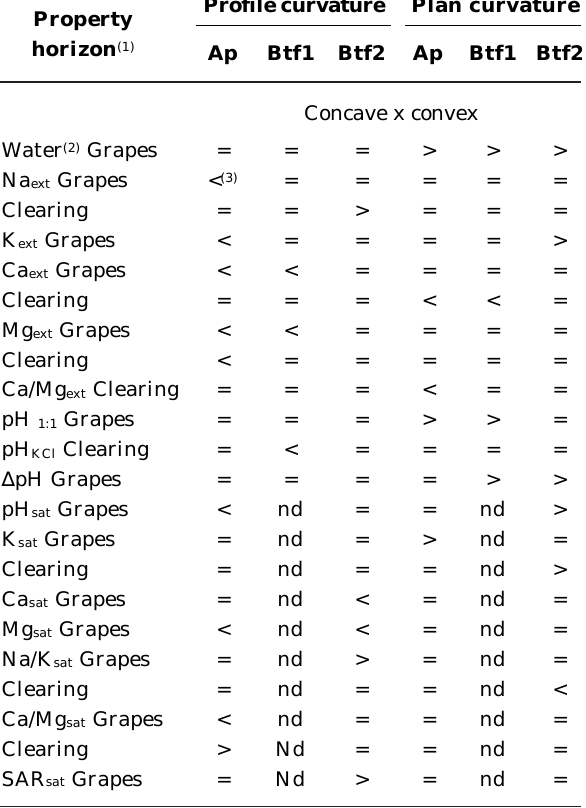
landscape elements with concave and convex surface curvature